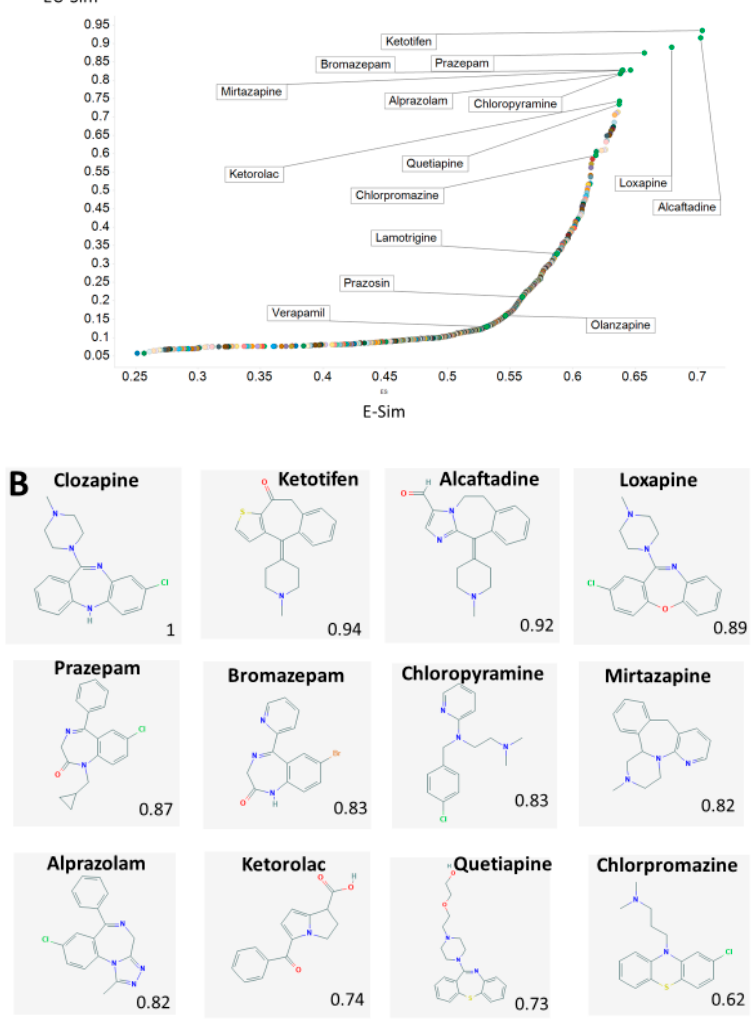
Figure 5. Similarity of drugs to clozapine as judged by the VAE. ( A ) Rank order of Euclidean similarity in 100 dimensions (E-Sim) or two UMAP dimensions (EU-Sim) as in Figure 3. Some of the “most similar” drugs are labelled, as are some of those in Table 1. ( B ) Structures of some of the drugs mentioned, together with their Euclidean distances as judged by VAE-Sim.